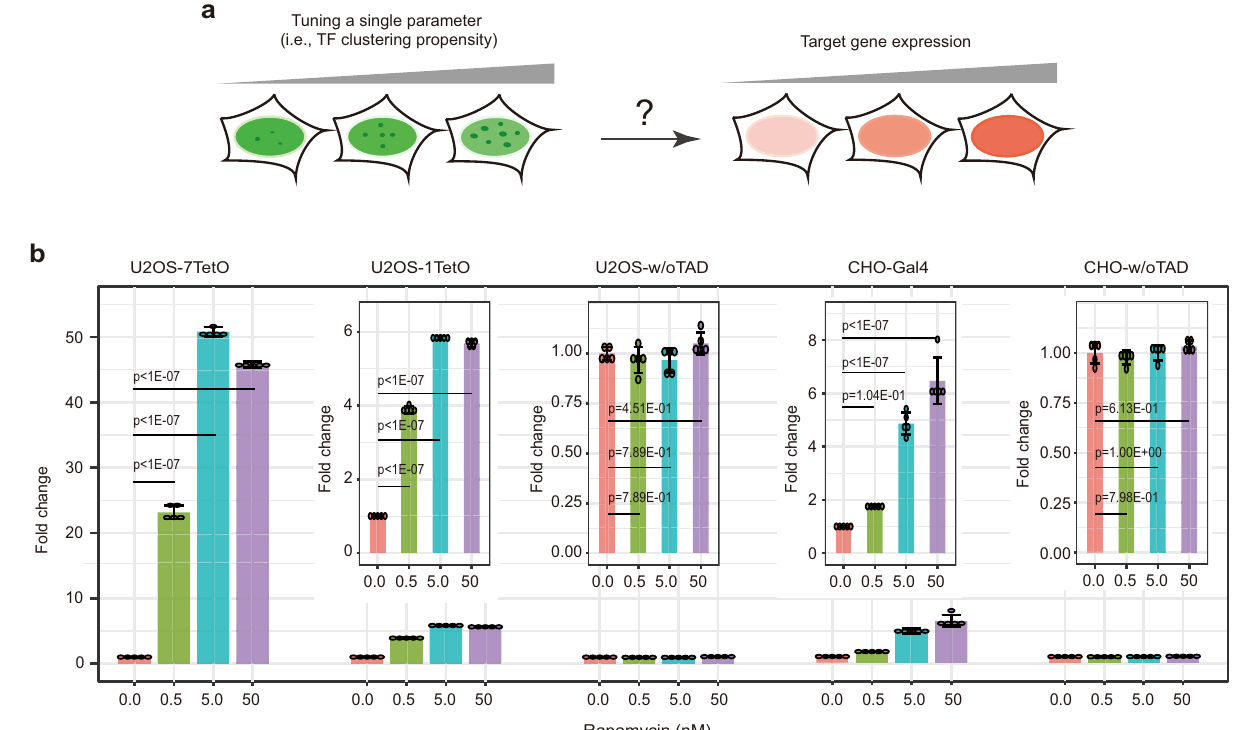
Fig. 2 TF clustering propensity modulates gene expression ampli fi cation. a Schematic of the experiment. b Flow cytometry quanti fi cations of the reporter response under various TF clustering propensity conditions for fi ve separate synthetic systems. In all conditions, iRFP fl uorescence levels were quanti fi ed 72 h post the addition of doxycycline (0.5 μ g/ml for U2OS cells and 0.1 μ g/ml for CHO cells) and indicated rapamycin concentration. Fold change was calculated by normalizing to zero rapamycin condition. U2OS-7TetO: Monoclonal U2OS cells containing the system depicted in Fig. 1a; U2OS-1TetO: Analogous to U2OS-7TetO except that the reporter gene contains only 1x TetO site; U2OS-w/oTAD: Polyclonal U2OS cells containing the system depicted in Fig. 1a except that the rTetR is not fused to a trans-activation domain; CHO-Gal4: Monoclonal CHO cells containing the system depicted in Supplementary Fig. 1e; CHO-w/oTAD: Polyclonal CHO cells containing the system depicted in Supplementary Fig. 1e except that the Gal4 is not fused to a trans-activation domain. Data are presented as mean ± S.D. ( n = 5 biological replicates). p values were calculated by one-way ANOVA and TukeyHSD. Source data are provided, which contain details of statistical